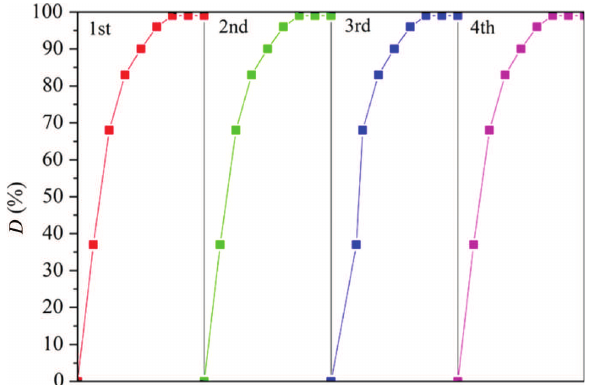
Figure 11: Map of MO degradation used Cu 2 O/ZnO (sample II) repeatedly (catalyst 0.1 g; initial concentration of MO 50 mg/l; pH 6.8).